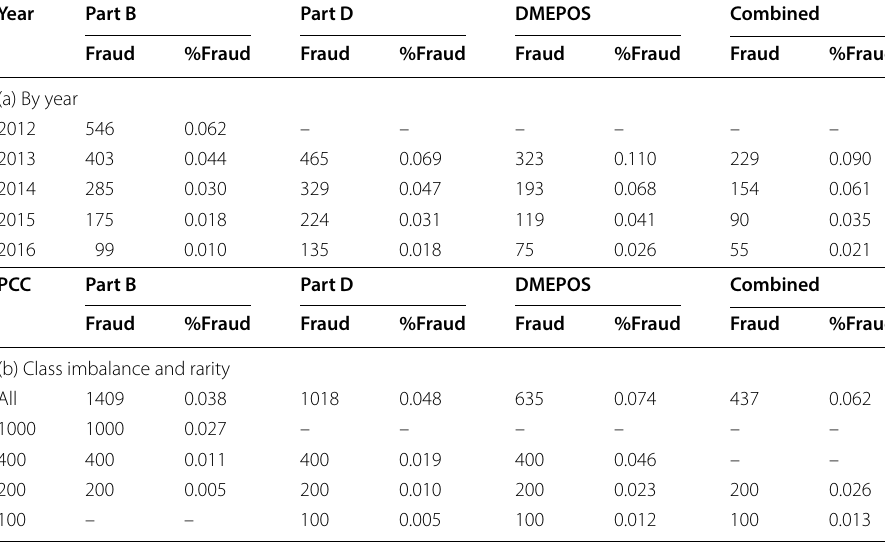
Table 4 Summary of Medicare